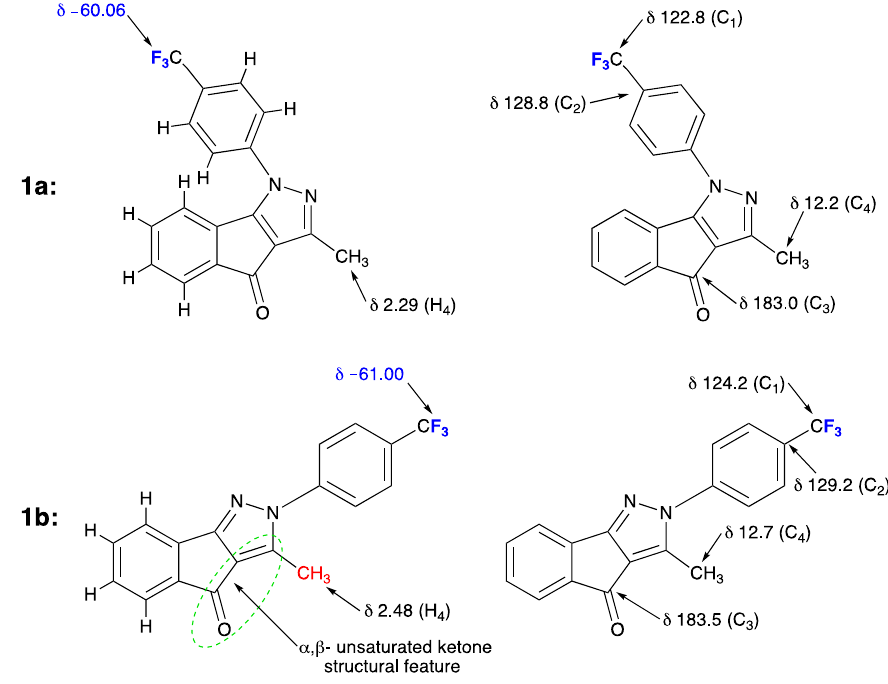
Figure 4. Key 19 F, 1 H, and 13 C NMR assignments for compounds 1a and 1b .